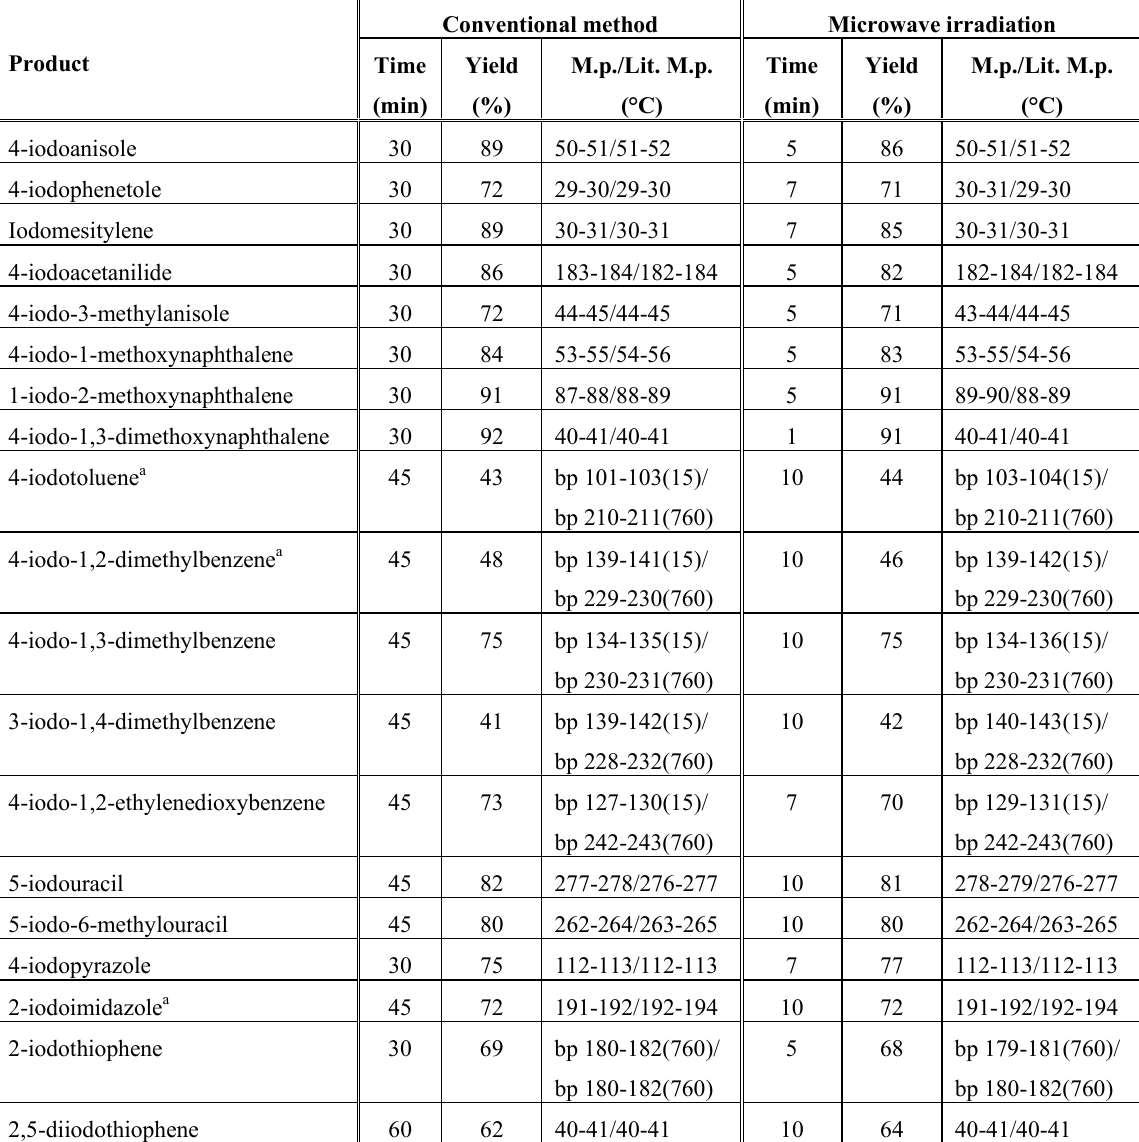
Table 1. Pure iodinated products prepared. The literature m.p. or b.p. are taken from Ref. 13. Conventional